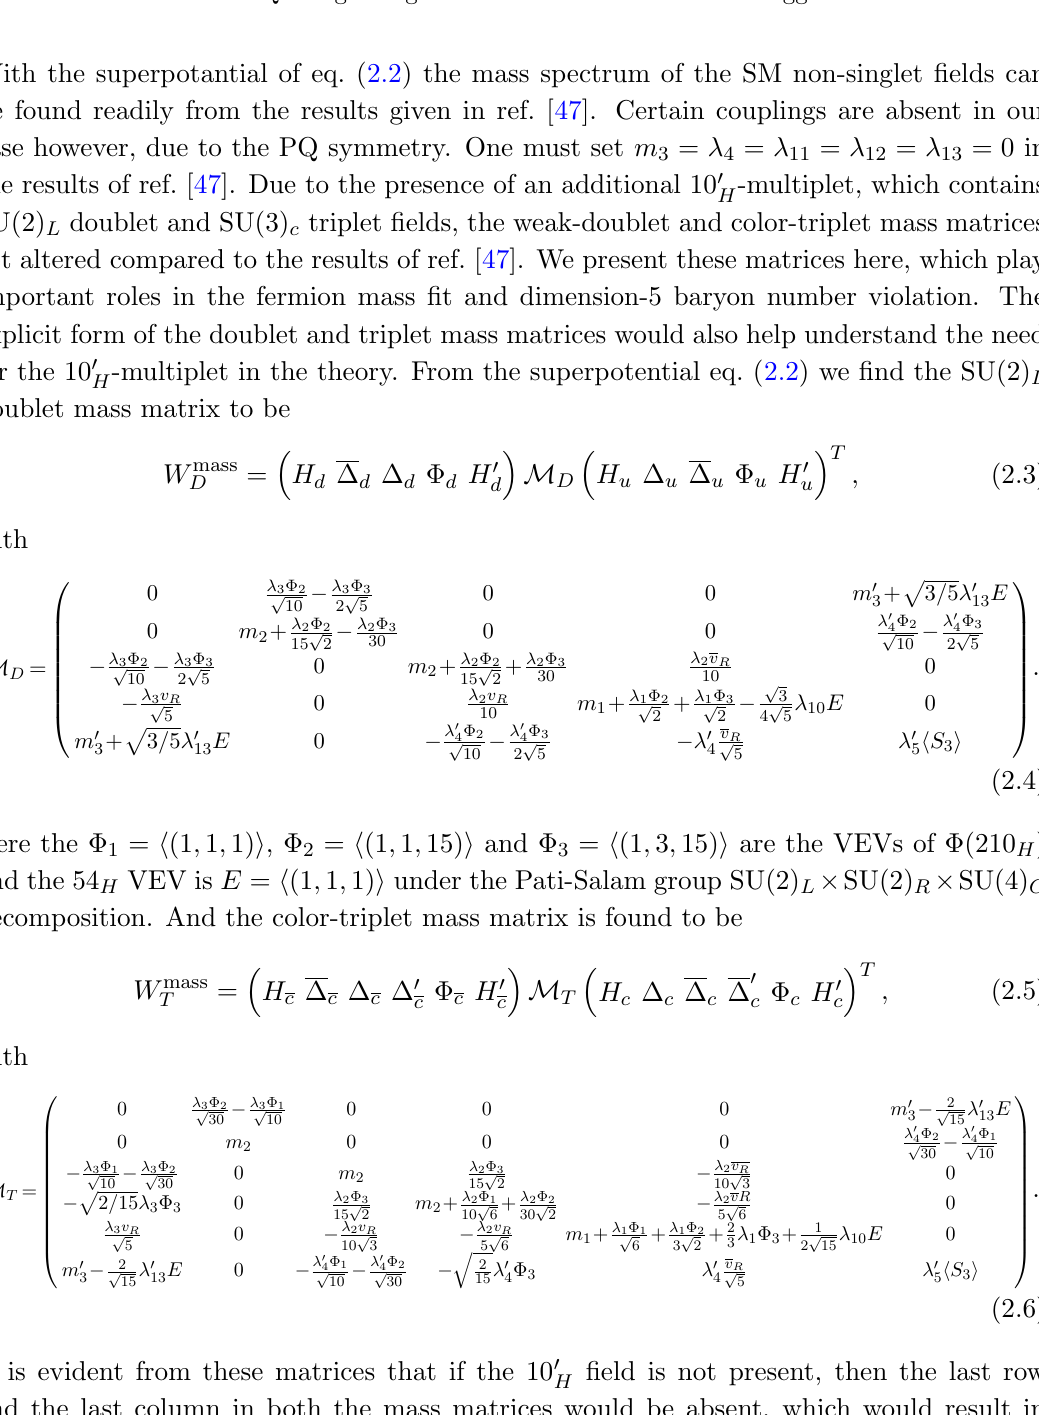
Table 1 . PQ charge assignment of the fermions and the Higgs